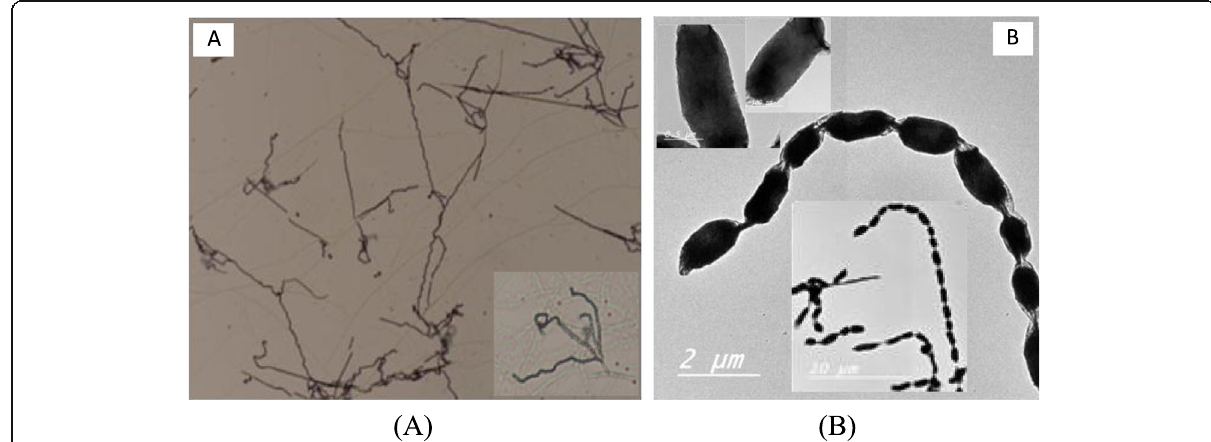
Fig. 2 a Light microscopy images of the aerial mycelium showing a spiral spore chain type (G x 400) for 14 days at 28 °C. b Scanning electron micrographs are showing smooth spore surface ornamentation (× 7, 500) of Streptomyces sp. SBLWN_MH2 grown on a starch nitrate medium for 21 days at 28